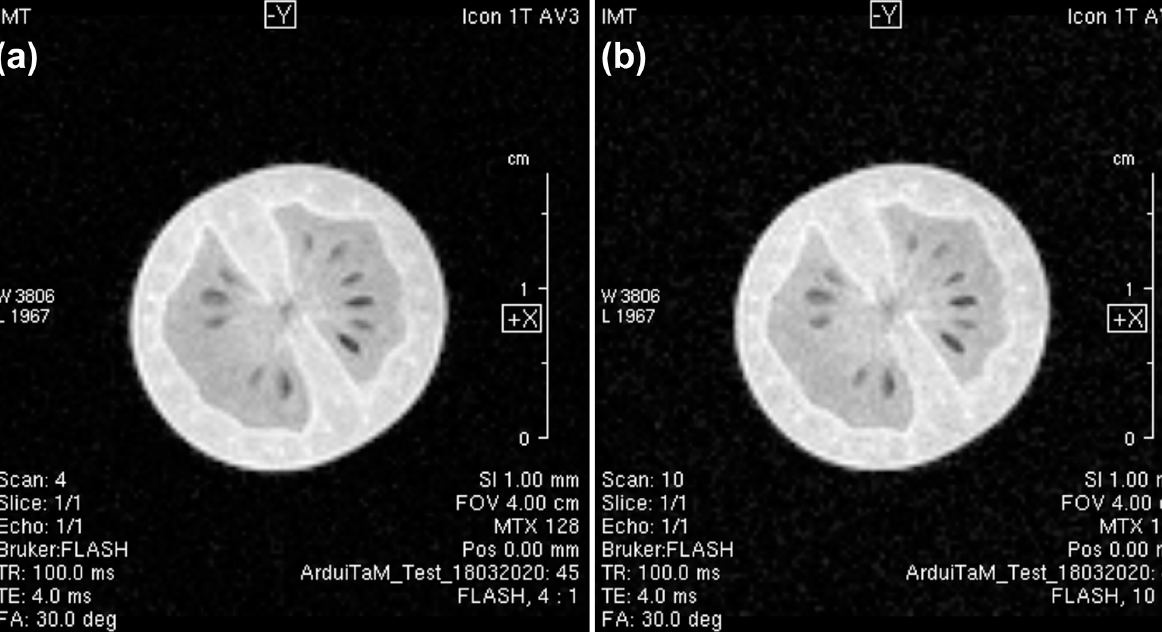
Figure 9. Integrating the ArduiTaM with a commercial MRI scanner shows only a negligible effect on its performance. (a) MR image of a cherry tomato before applying the ArduiTaM. The measured SNR is 49. (b) Repeating the same experiment after applying the ArduiTaM. The measured SNR here is 43, reflecting a loss of approximately 12%, due to the insertion loss of the RF switch (ZFSWA-2-46 from Mini-Circuits ®